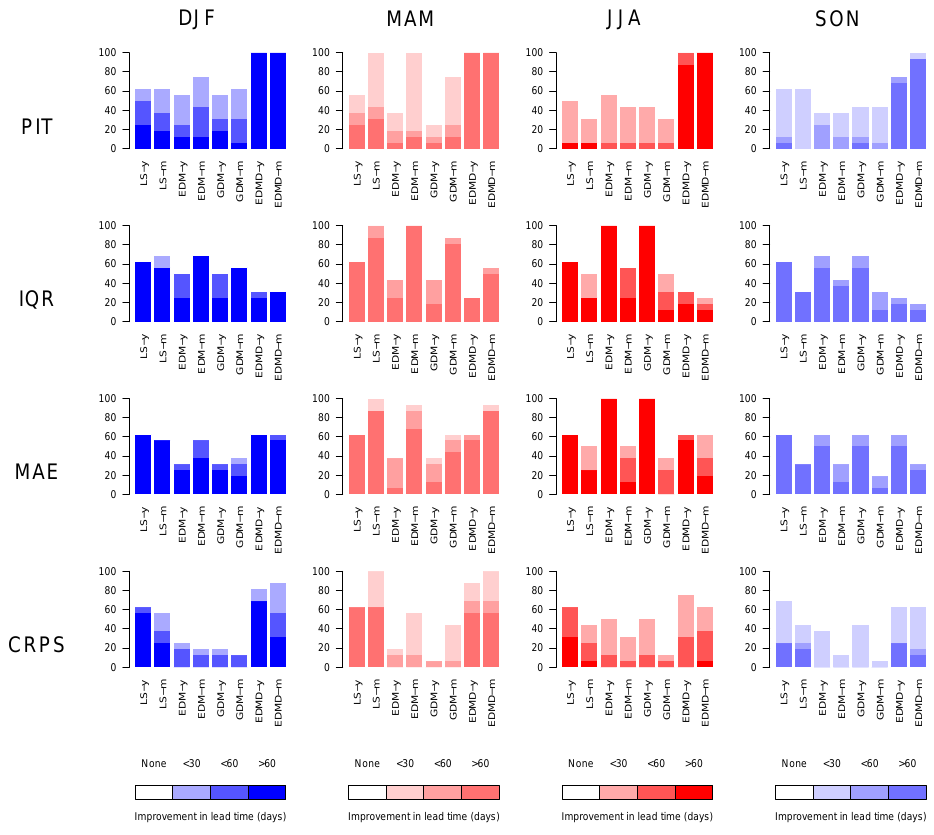
Figure 7. Fraction of catchments (%) in each UFL value category, i.e. fraction of catchments in which bias corrections increase the lead time up to which seasonal precipitation forecasts have skill with respect to raw seasonal precipitation forecasts. Each row corresponds to an evaluation criterion and each column corresponds to a season. Colour shades indicate the UFL category, i.e. the lead time up to which precipitation forecasts are